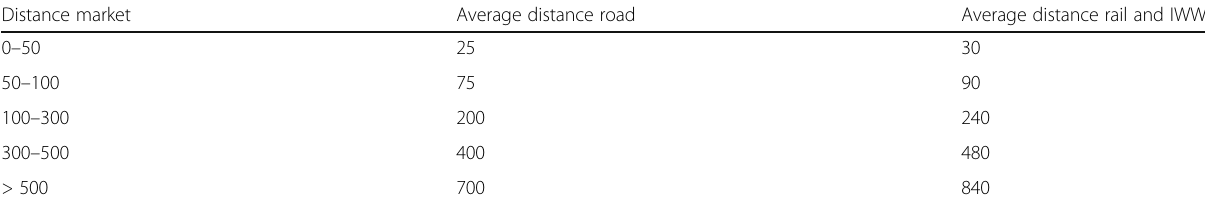
Table 8 Assumed average distances in the distance markets Distance